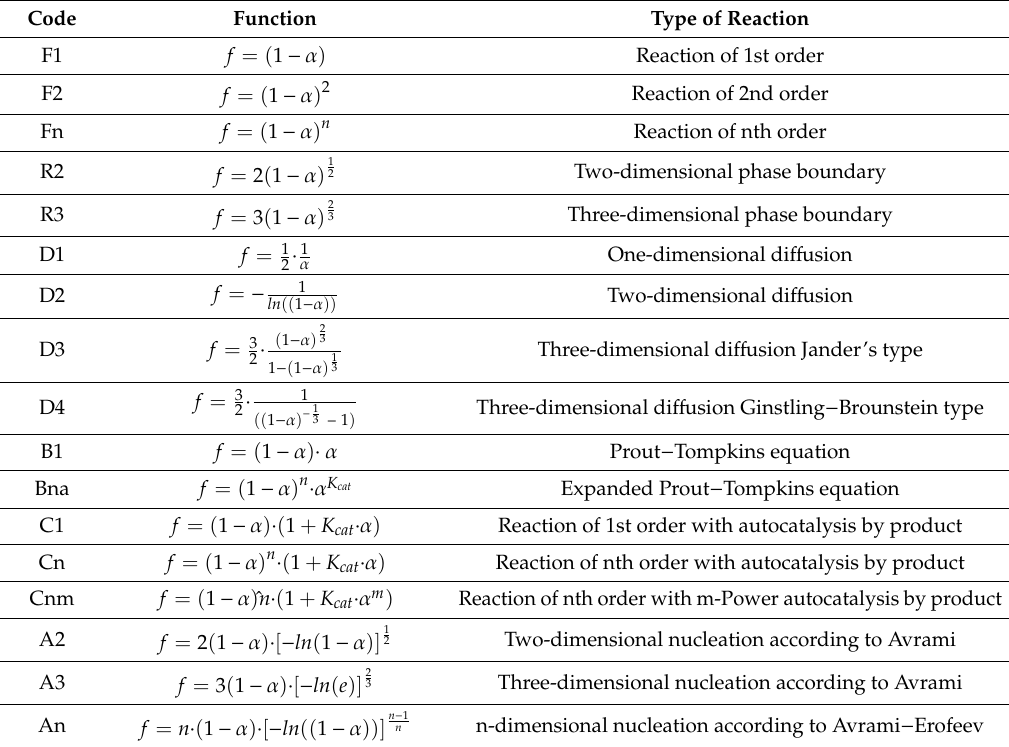
= − A e E RT f ( α dt